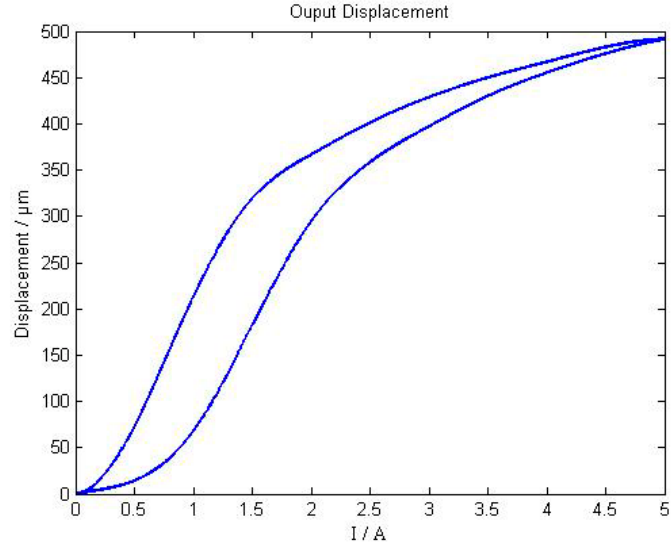
Figure 11. Hysteresis loop under the action of current 5 A and preloading 10 MPa.